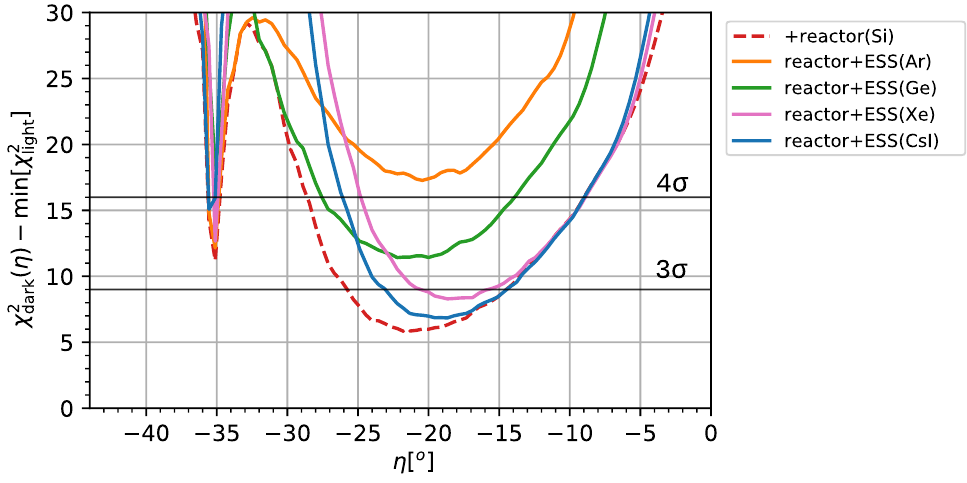
Figure 9 . Sensitivity to exclude the LMA-dark degeneracy by a hypothetical CE ν NS measurement at a nuclear reactor combined with ESS. The red-dashed curve corresponds to a Si target at a reactor. For the solid curves we combine reactor (Si) with measurements at the ESS assuming Ar, Ge, Xe, and CsI targets, see section 4.1 for